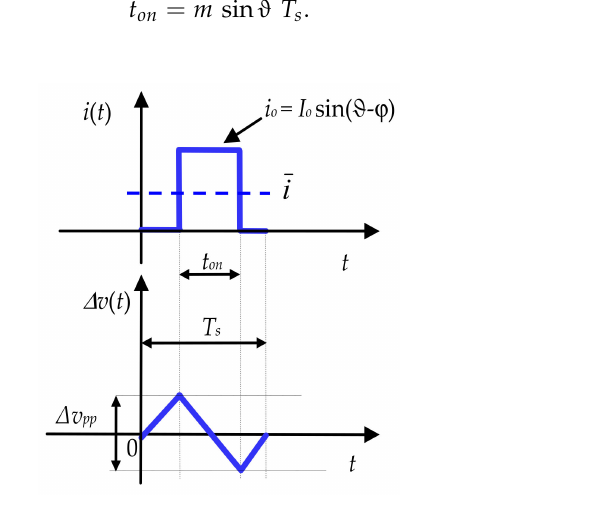
Figure 4. Instantaneous input current and DC-link voltage over a switching period T s